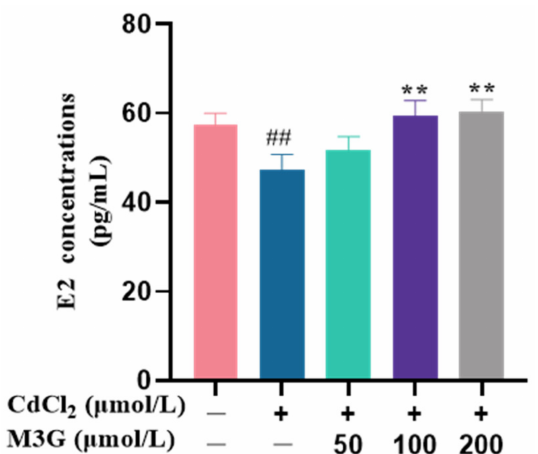
Figure 2. M3G increases E2 levels in CdCl 2 -exposed KGN cells. E2 concentrations of KGN cells treated with 10 µ mol/L CdCl 2 and 50-200 µ mol/L M3G for 24 h. Mean ± SD, n = 3. ## p < 0.01, vs. control; ** p < 0.01, vs. CdCl 2 -treated